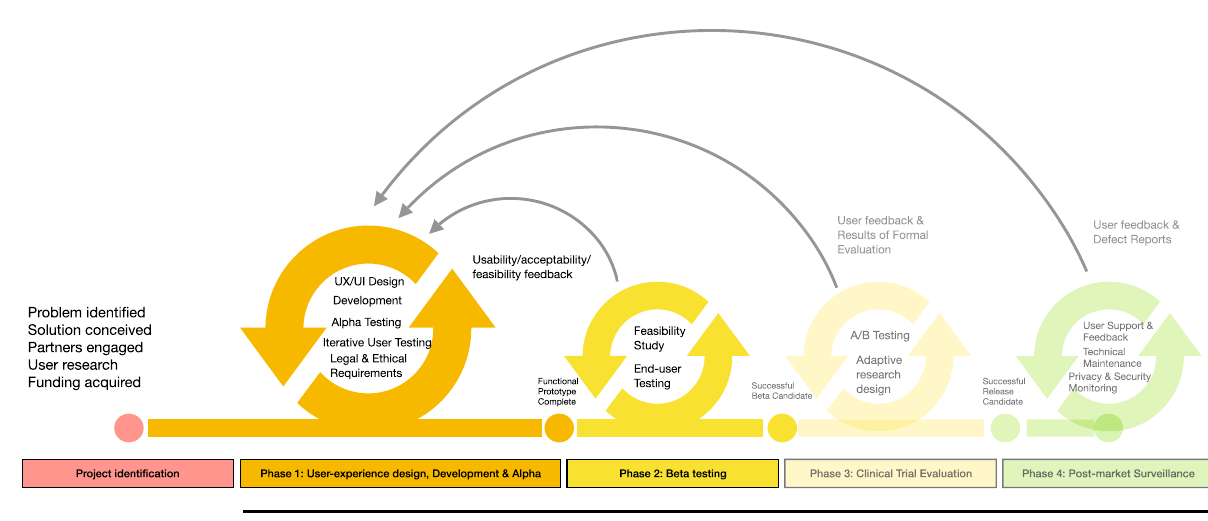
Fig. 6 The mHealth Agile Development & Evaluation Lifecycle (Wilson et al. 25 ) adapted with permission to the ACTsmart development